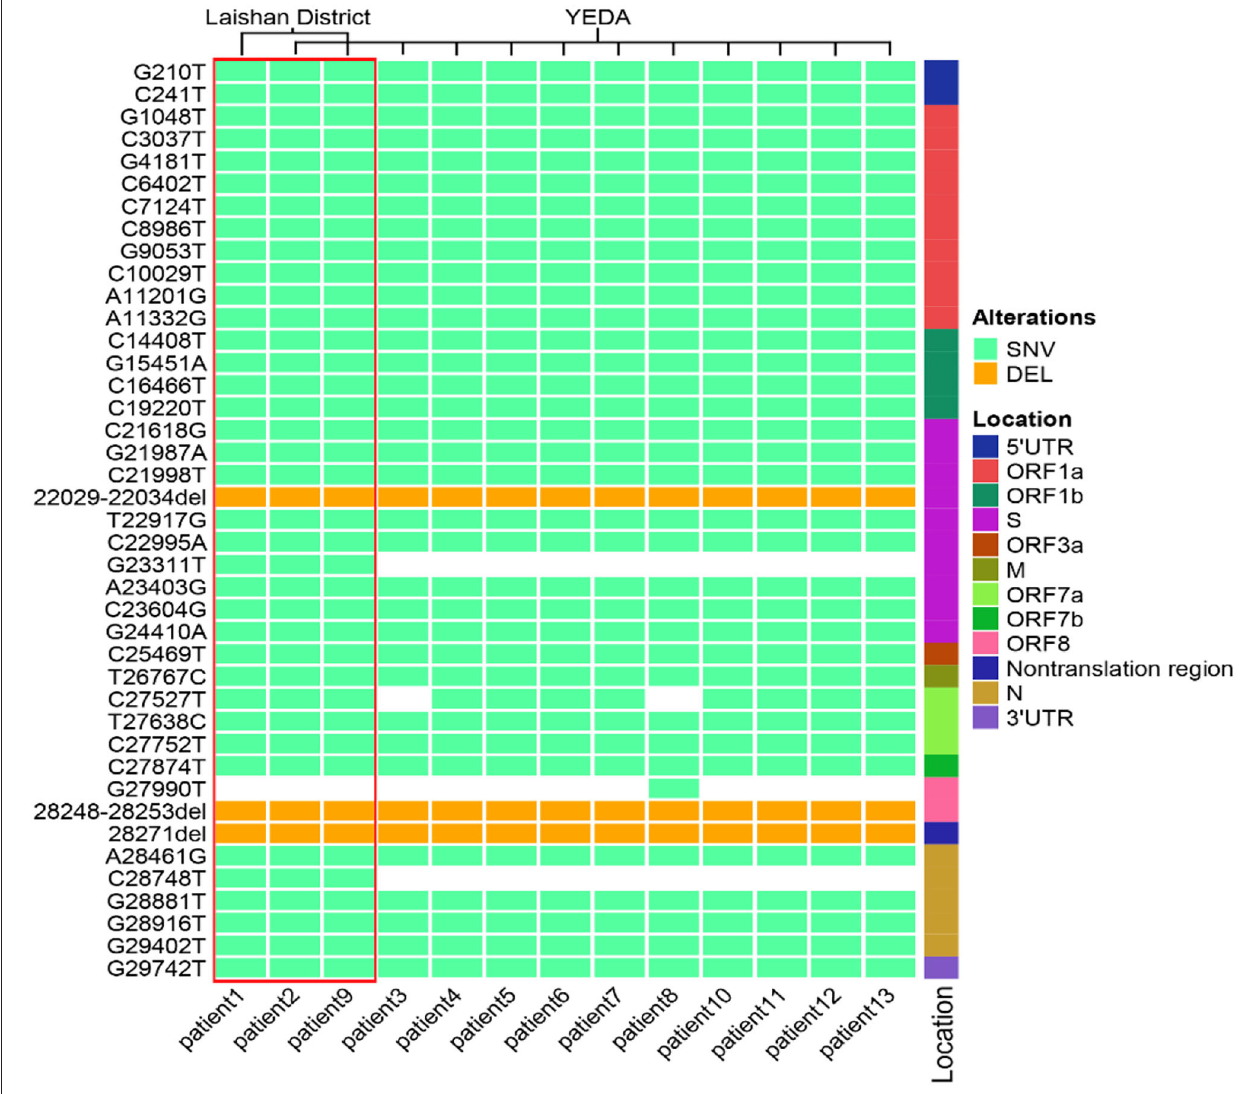
quality control were positive, and an ideal logarithmic curve was